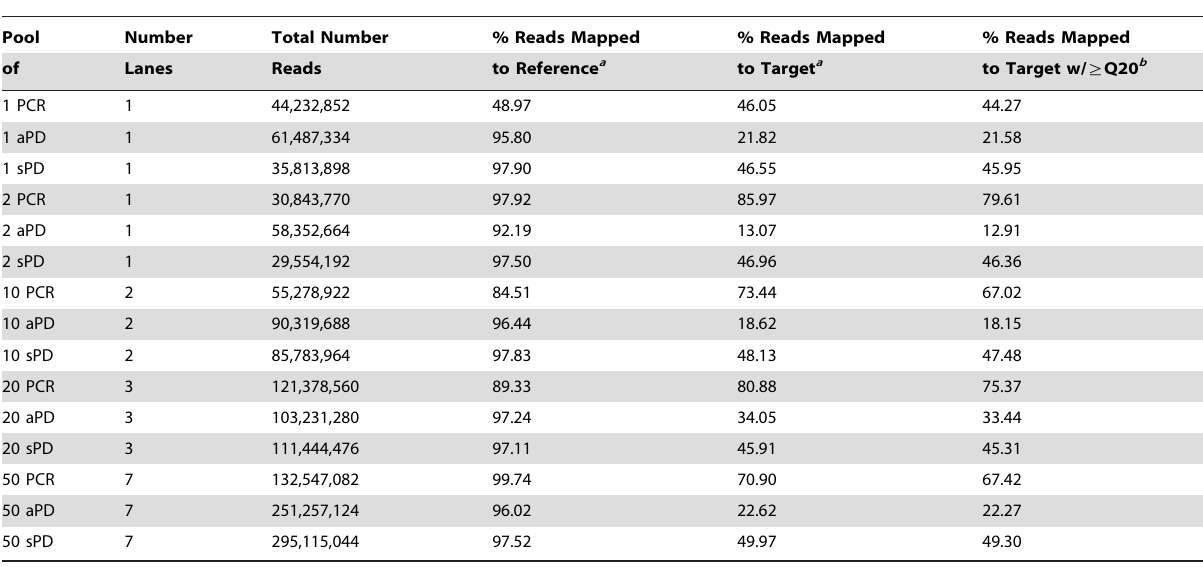
Table 1. Target sequence enrichment success before duplicate